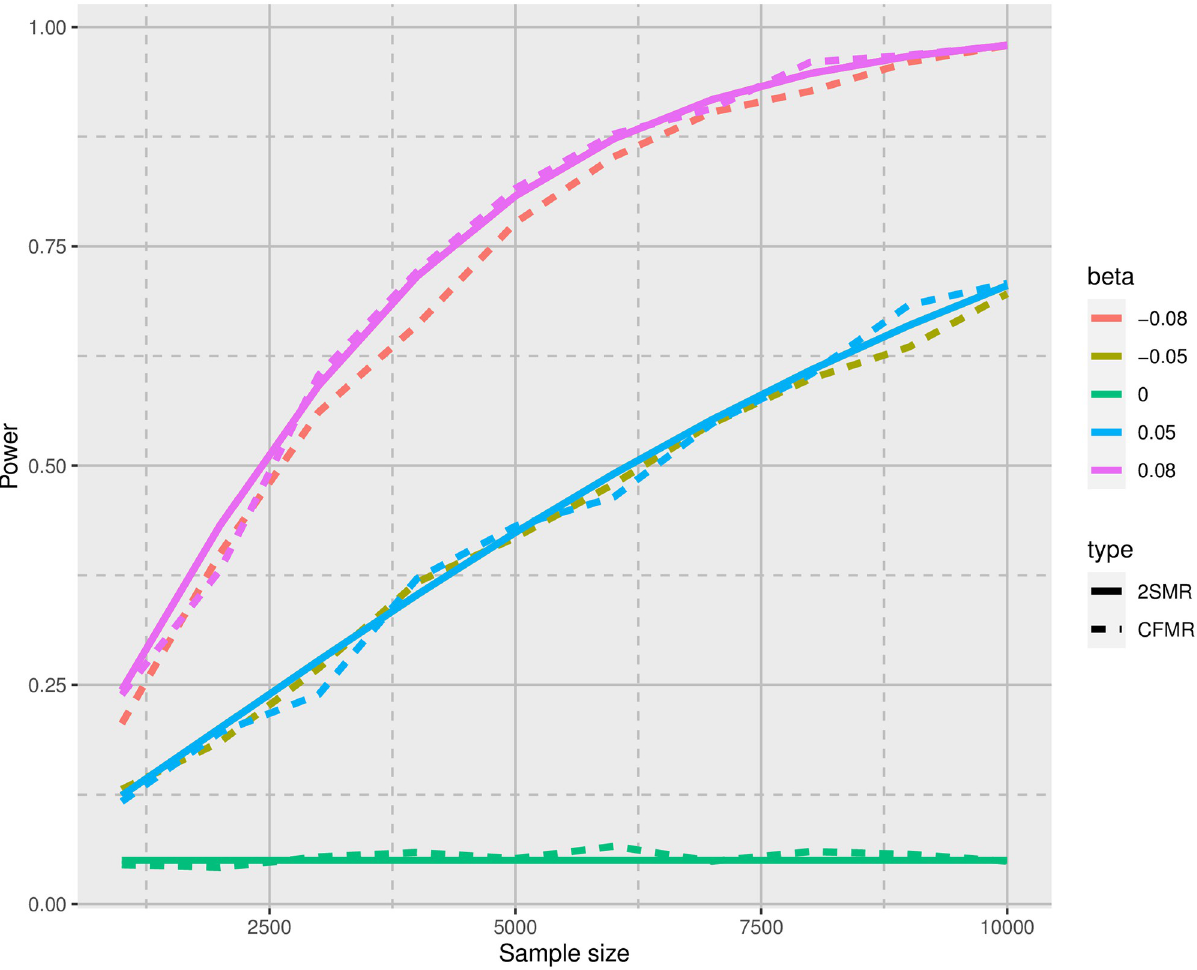
Fig 2. Power curves for CFMR versus two-sample MR (2SMR) using the simulation setup described in the Simulations section in the main text (with h 2 = 20%). The dashed lines represent power curves for CFMR, while the solid lines represent the theoretical power for 2SMR [24]. Note that the solid pink line covers the solid red line perfectly (top part of the graph). These lines fully overlap as a result of symmetry. Given that the solid lines are generated from the theoretical power formula of two-sample MR (see Deng et al. [24]), the red and pink curves correspond to the same effect size (in terms of magnitude) but have opposite signs. The same is the case for the solid blue and gold lines in the middle part of the